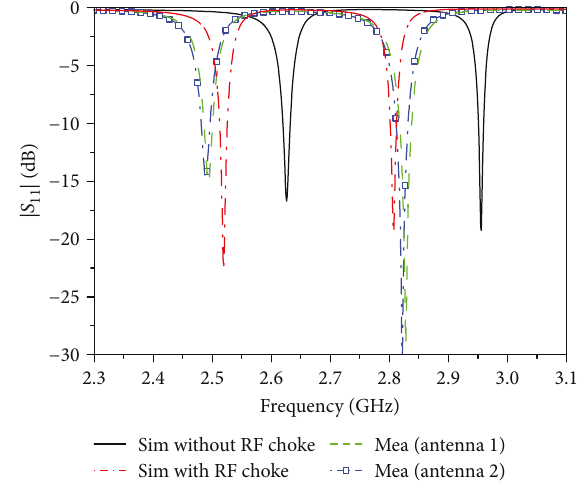
Figure 2: Simulated and measured results of the proposed recon fi gurable antenna.